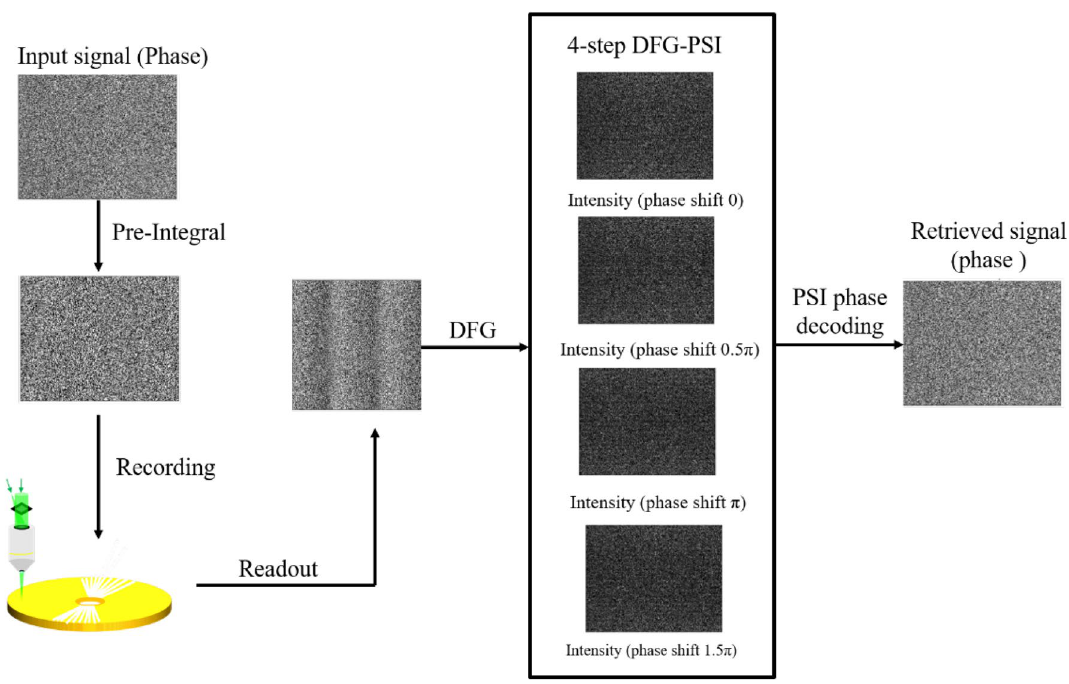
Figure 4. The flowchart of the proposed